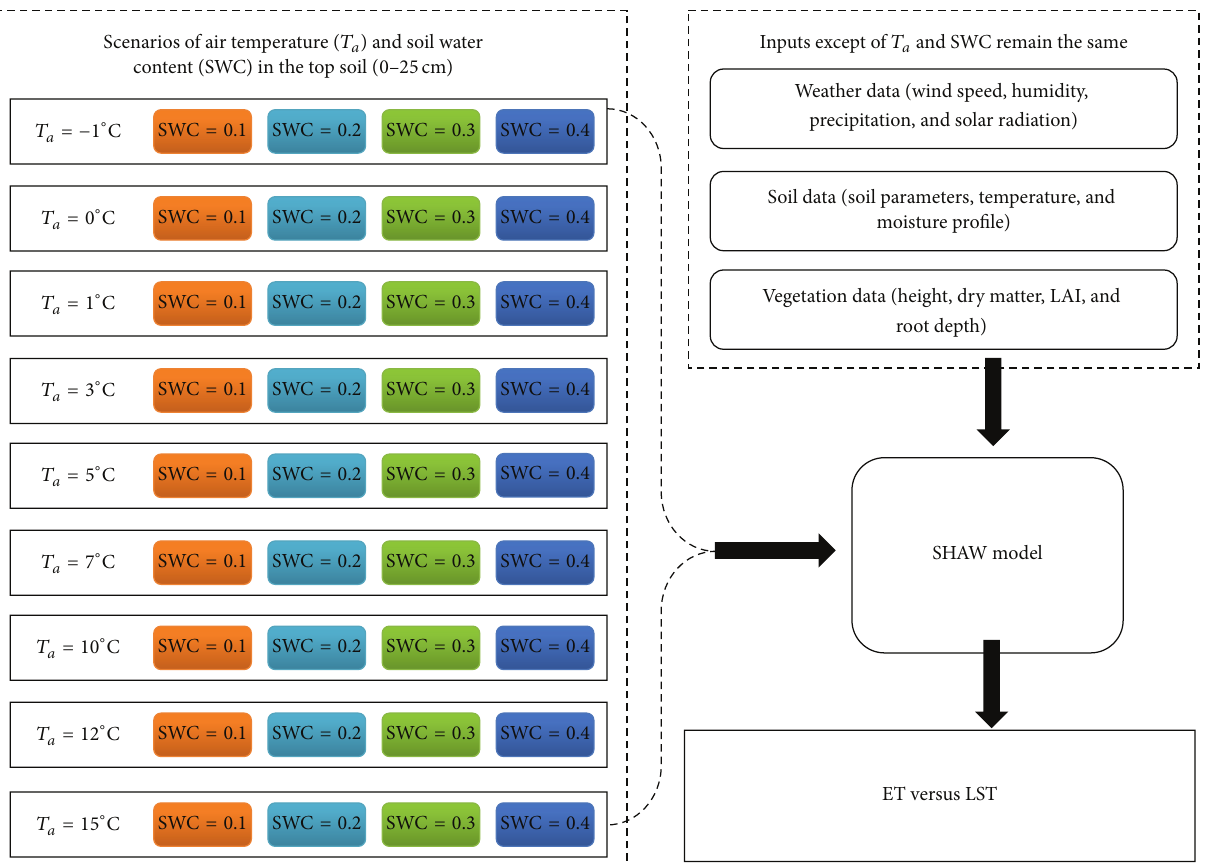
Figure 1: Strategies to simulate ET and LST using the SHAW